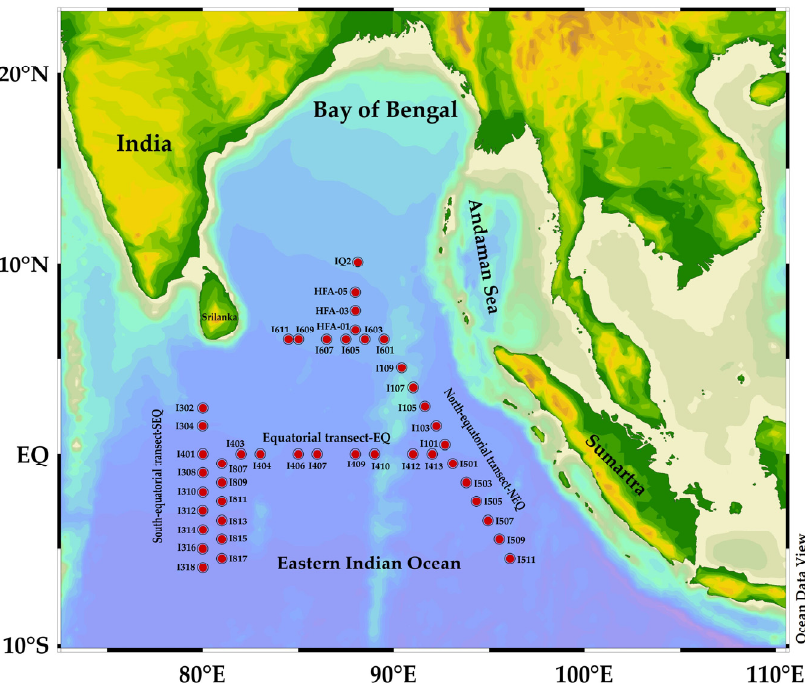
Figure 1. Sampling stations along the Eastern Indian Ocean during spring 2014: 17 stations described by divisions, such as north-equatorial region (NEQ) at longitude 90° E, equatorial region (EQ) at latitude 0, and south-equatorial region (SEQ) at longitude 80° E.